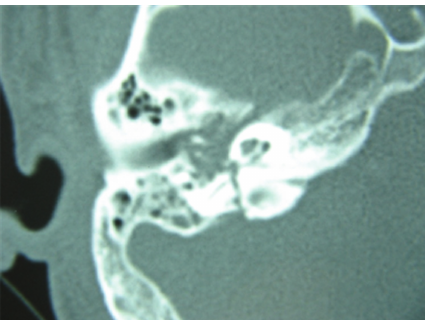
Figure 1: Transverse fracture of the temporal bone involving the midportion of the vertical segment is seen as an axial cut of the right temporal bone.